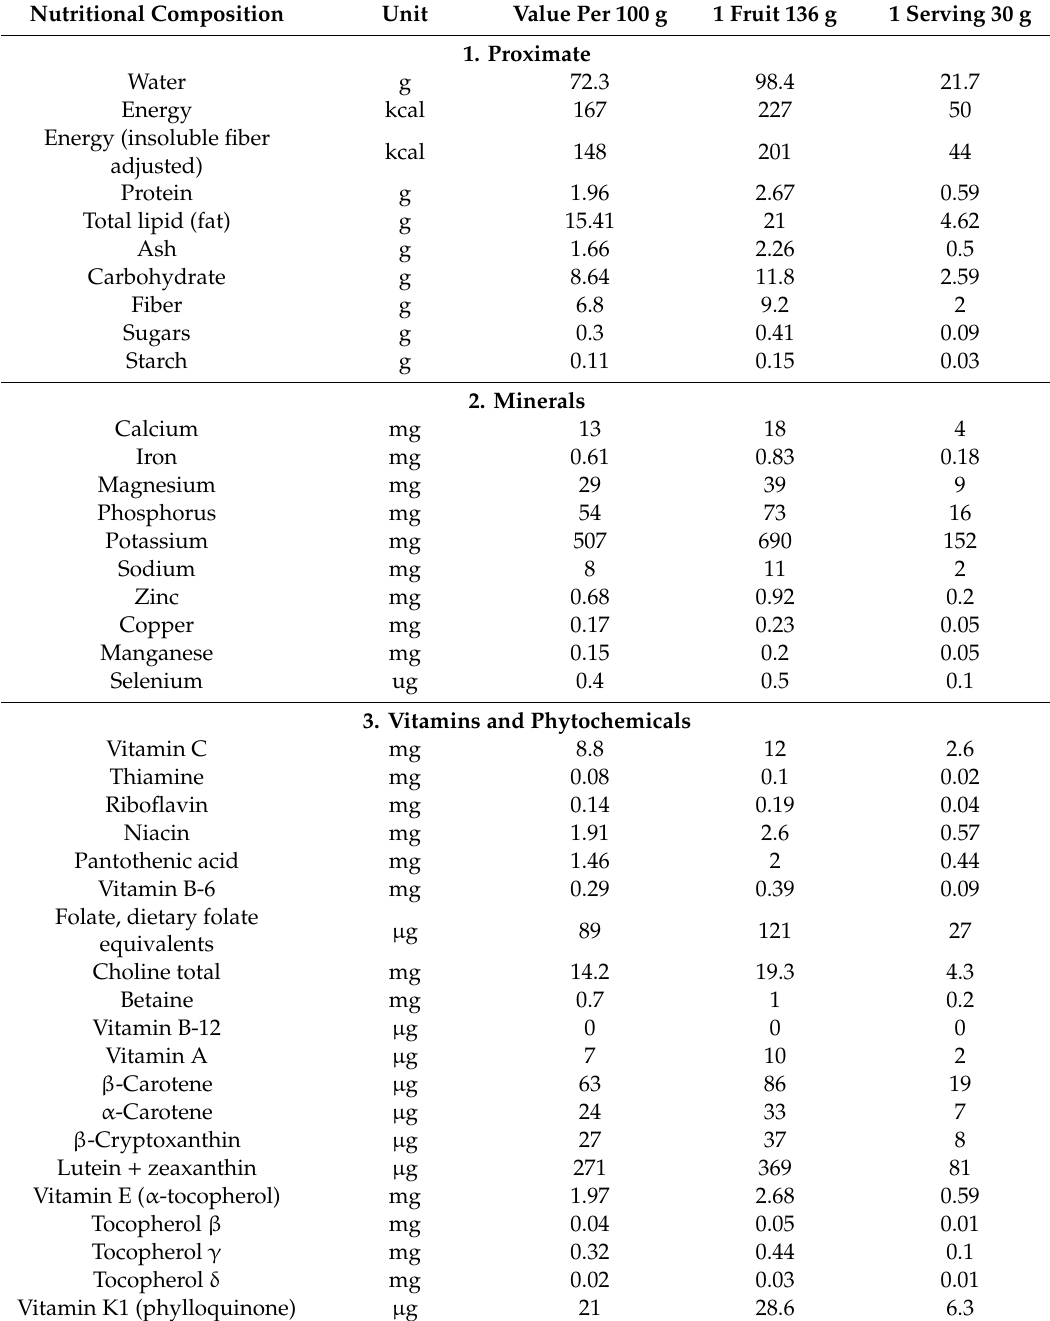
Table 2. Pulp composition of Persea americana (avocado)